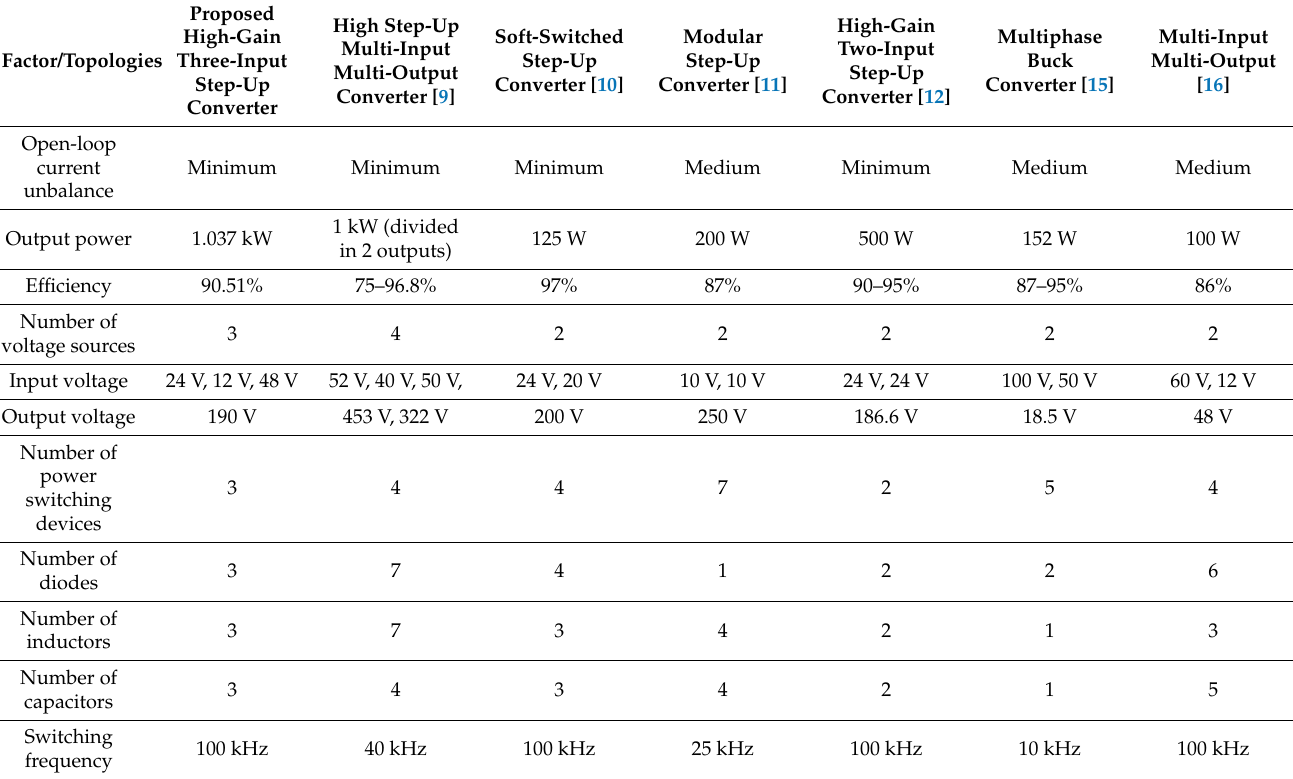
Table 3. A comparison between the proposed converter and similar